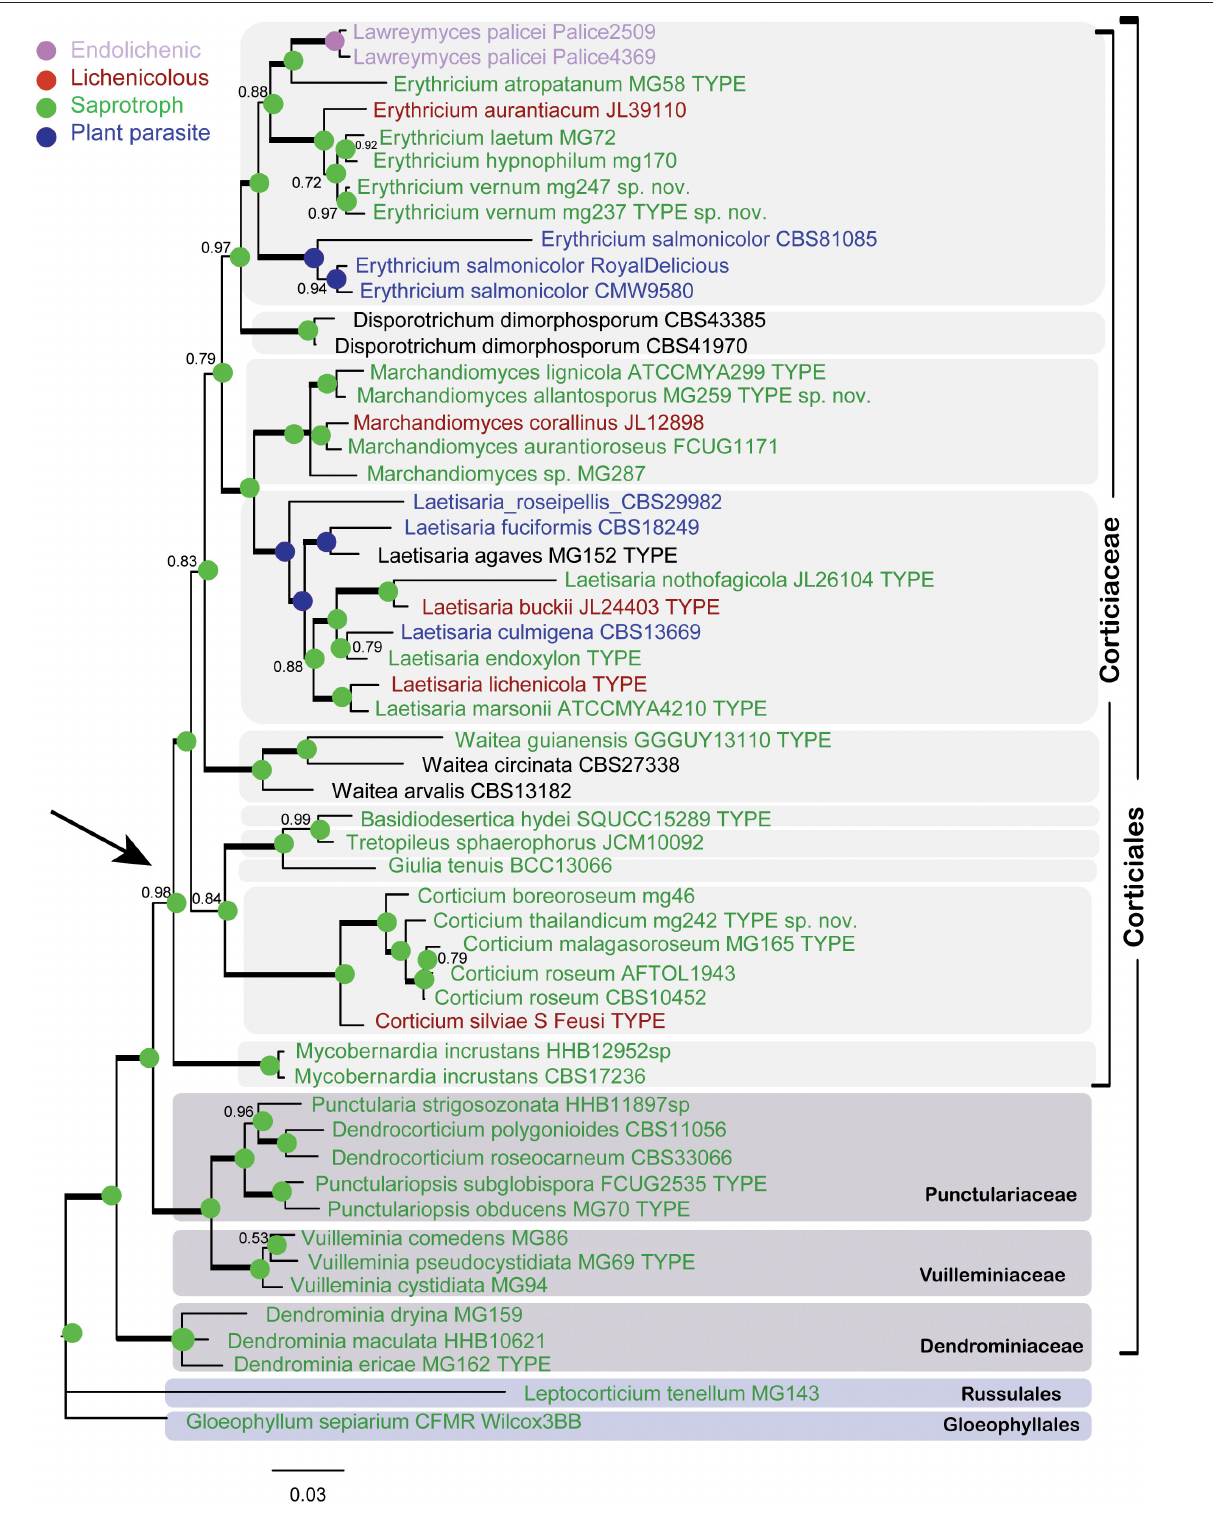
Frontiers in Microbiology |